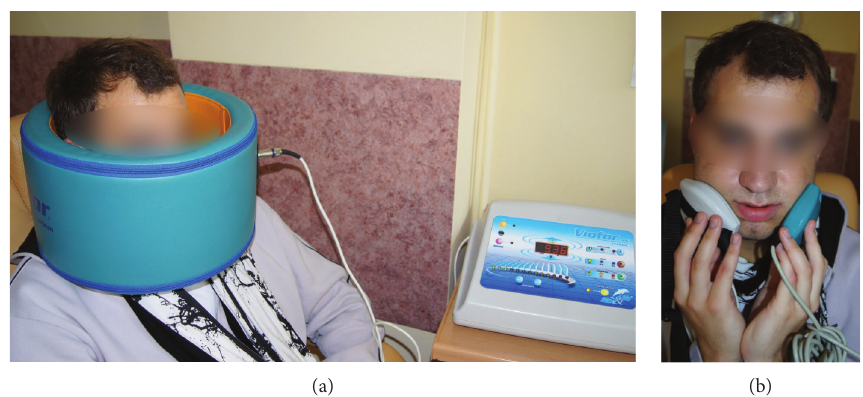
Figure 1: (a) and (b). Treatments with an ELF EMF, ring applicator, and elliptic applicators.